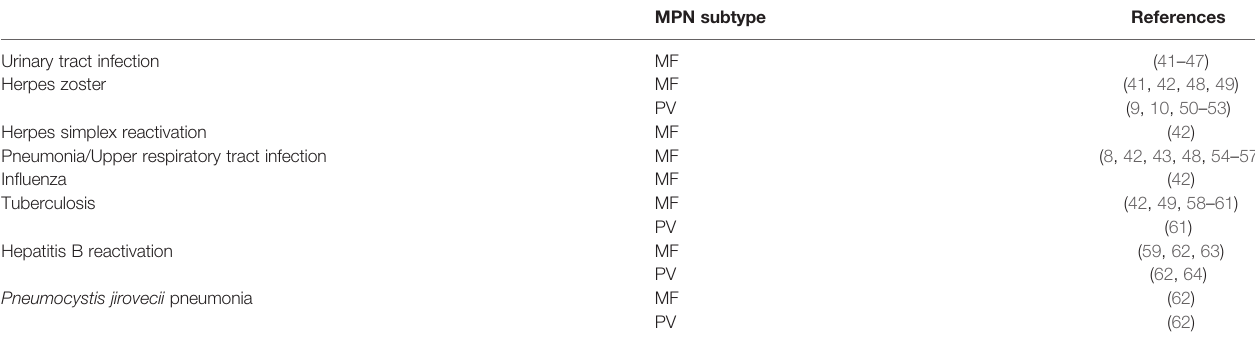
TABLE 2 | JAK inhibitors-associated infectious